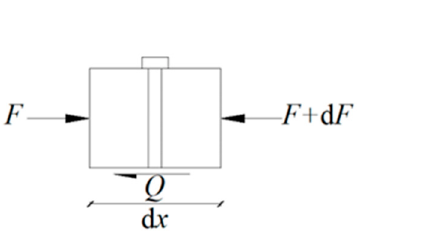
Figure 6. Equilibrium relation of timber–steel interface. Relative slip equation of bolt distance in elastic limit state